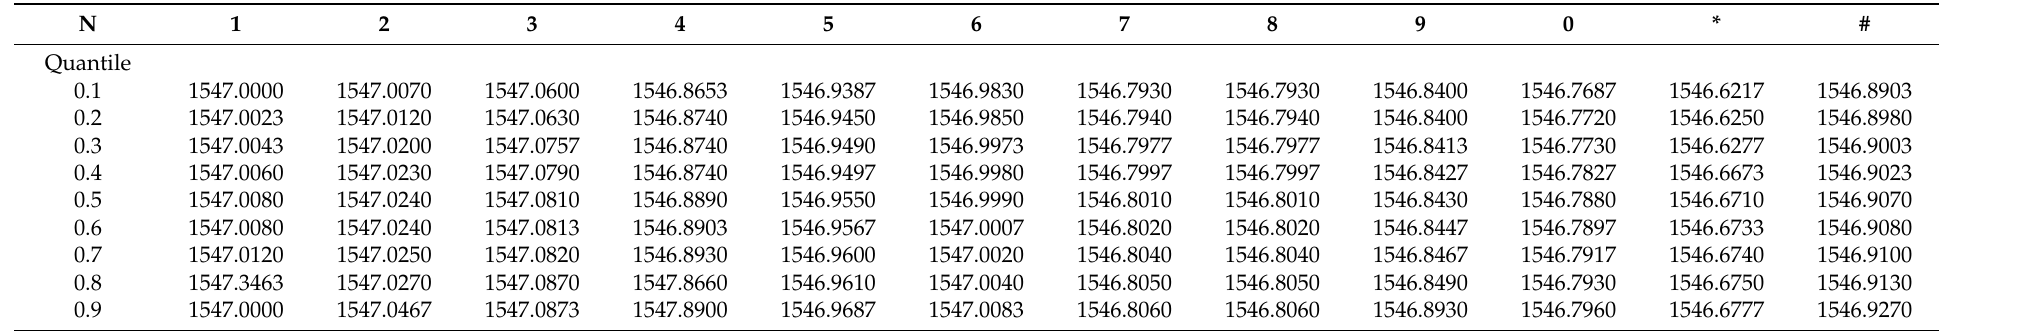
Table A1. Wavelength of Subject Phone Number